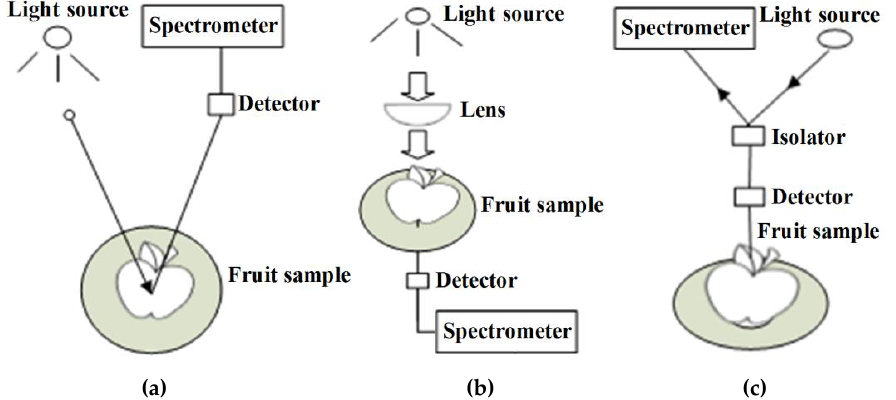
Figure 3. ( a ) Schematic diagram of reflection detection. ( b ) Schematic diagram of transmission detection. ( c ) Schematic diagram of diffuse reflection detection. Table 3. Three main infrared detection technologies.